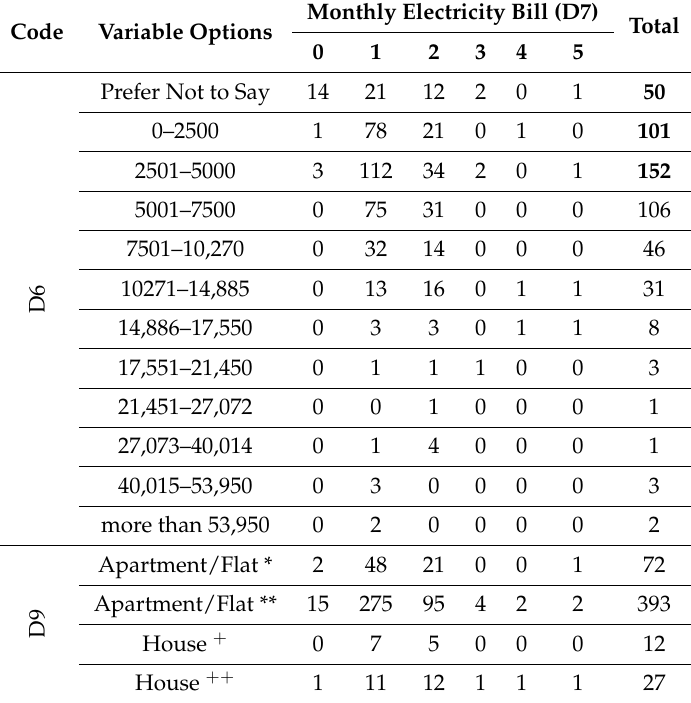
Table 3. Cross tabulation of monthly net household income in TL (D6) and type of residence (D9) with the month electricity expense in TL (D7).